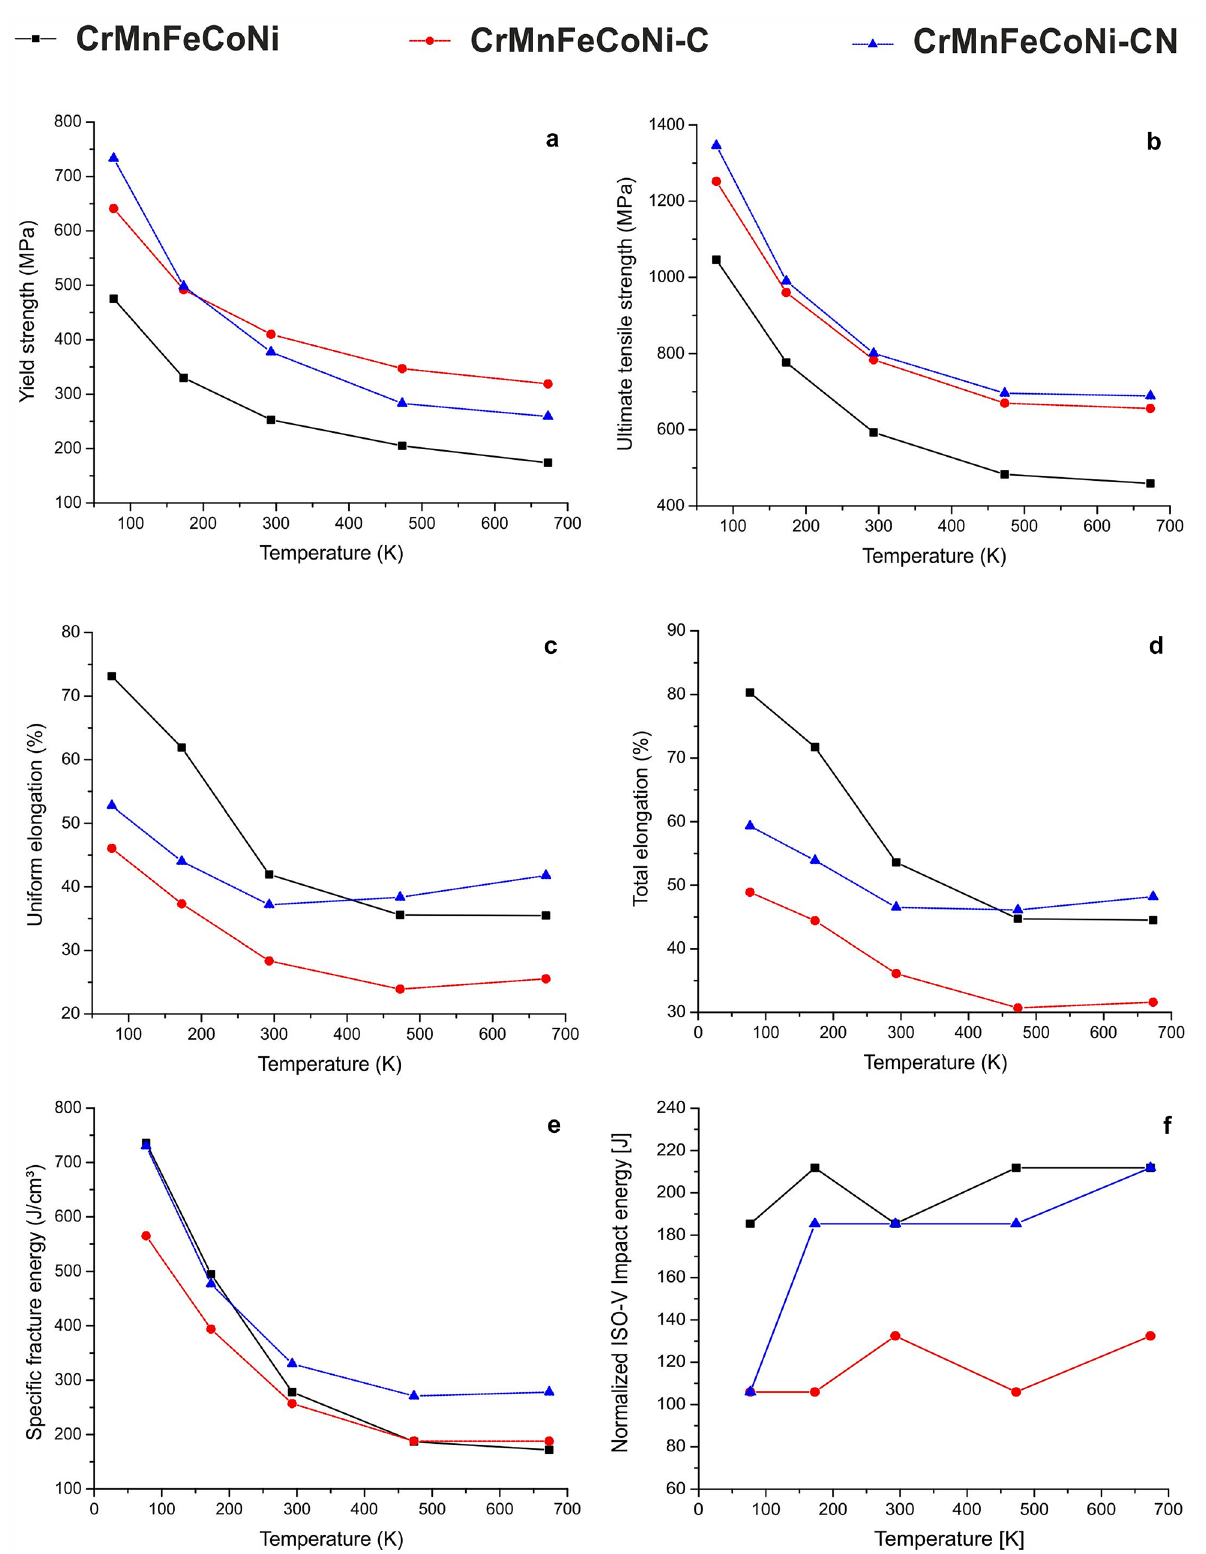
Fig. 4 Comparison of the strength and ductility of the high-entropy alloys: a yield strength, b ultimate tensile engineering strength, c uni- form elongation, d total elongation, e specific fracture energy, f normalized ISO-V impact energy of the